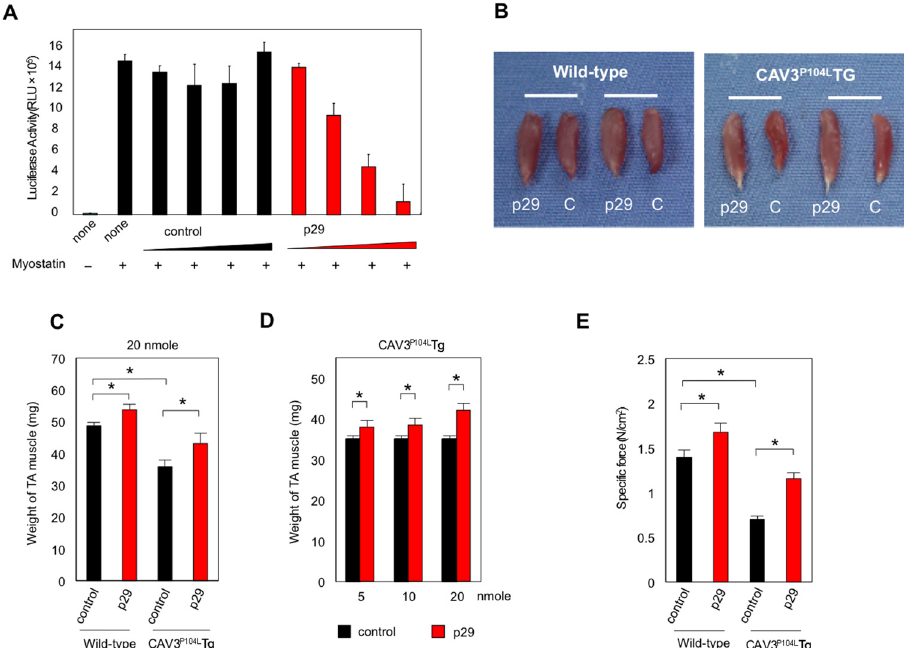
Fig 7. Intramuscular injection of p29 rescues muscle atrophy and weakness in caveolin 3-deficient LGMD1C model mice. ( A ) Effect of p29 on in vitro myostatin activity in the HEK293-(CAGA) 12 -luciferase system. Cells were stimulated with 10-ng/ml myostatin and simultaneously exposed to increasing concentrations (2, 20, 200, or 2000 nM) of p29 or albumin (control). All experiments were performed triplicate, repeatedly twice. ( B ) Appearance of TA muscles at 28 days after local injection of p29 (20 nmol) or albumin (C, control) into the ipsilateral and contralateral TA muscles of wild-type and CAV3 P104L Tg mice. ( C ) Weights of TA muscles injected with 20 nmol p29 or albumin in wild-type and CAV3 P104L Tg mice ( n = 10). * P < 0.05. ( D ) Weights of caveolin 3-deficient TA muscles injected with different amounts of p29 or albumin ( right , n = 10). * P < 0.05. ( E ) Specific force of the TA muscle in wild-type ( left ) and CAV3 P104L Tg ( right ) mice treated with p29 or albumin. * P < 0.05. Values are the means ± SD ( n =